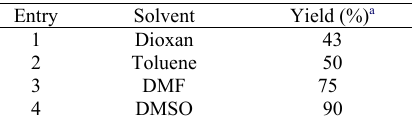
O ; (b) silica-encapsulated Fe 3 4